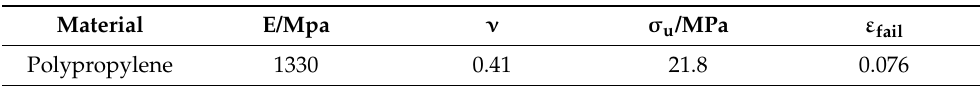
Table 3. Material parameters of the core